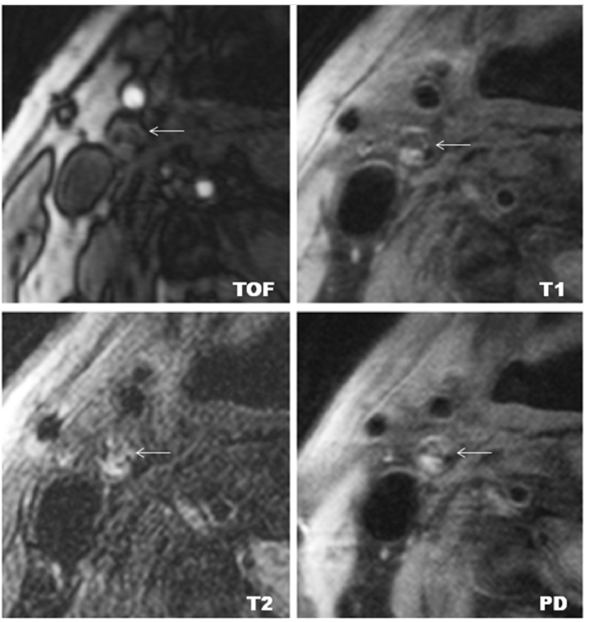
Variable Patients with MRI-defined Patients with MRI-defined P -value